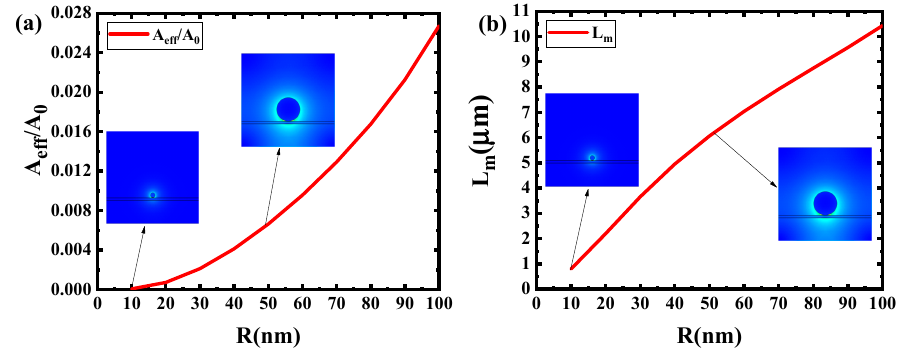
Figure 5. Dependence of normalized effective mode area and propagation length on the radius R at g = 1 nm: ( a ) A eff/ A 0 ( b ) L m.